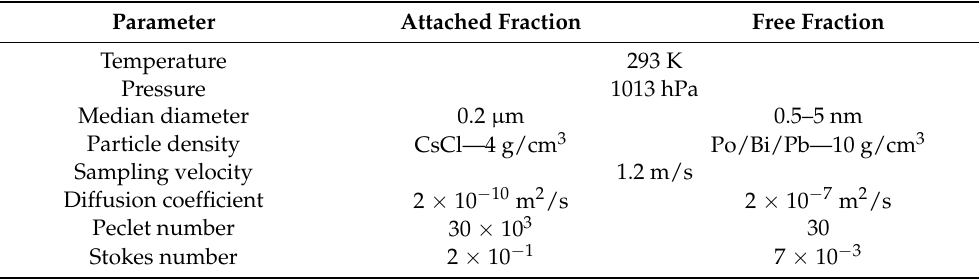
Table 1. Data for Stokes and Peclet numbers calculations (Equations (9-5), (9-8), (9-11) and (9-13)